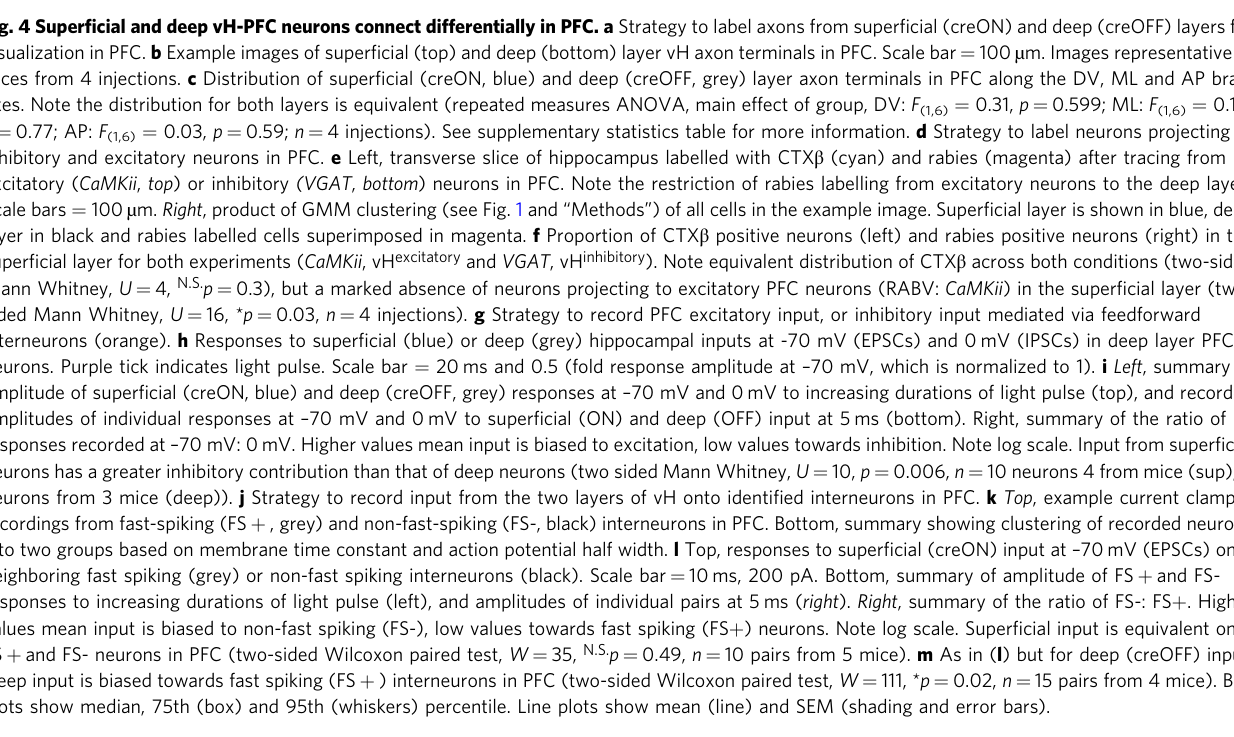
used an injection of AAV to express dlx mRuby into PFC to allow targeted whole cell recordings from inhibitory interneur- ons (Fig. 4j). Using this approach, we classi fi ed each interneuron as either fast spiking or non-fast spiking based on intrinsic electrophysiological properties (Fig. 4k), and then examined the relative input onto neighboring pairs of neurons of each type from either the super fi cial or deep layer of vH. Super fi cial vH input innervated both fast-spiking and non-fast-spiking